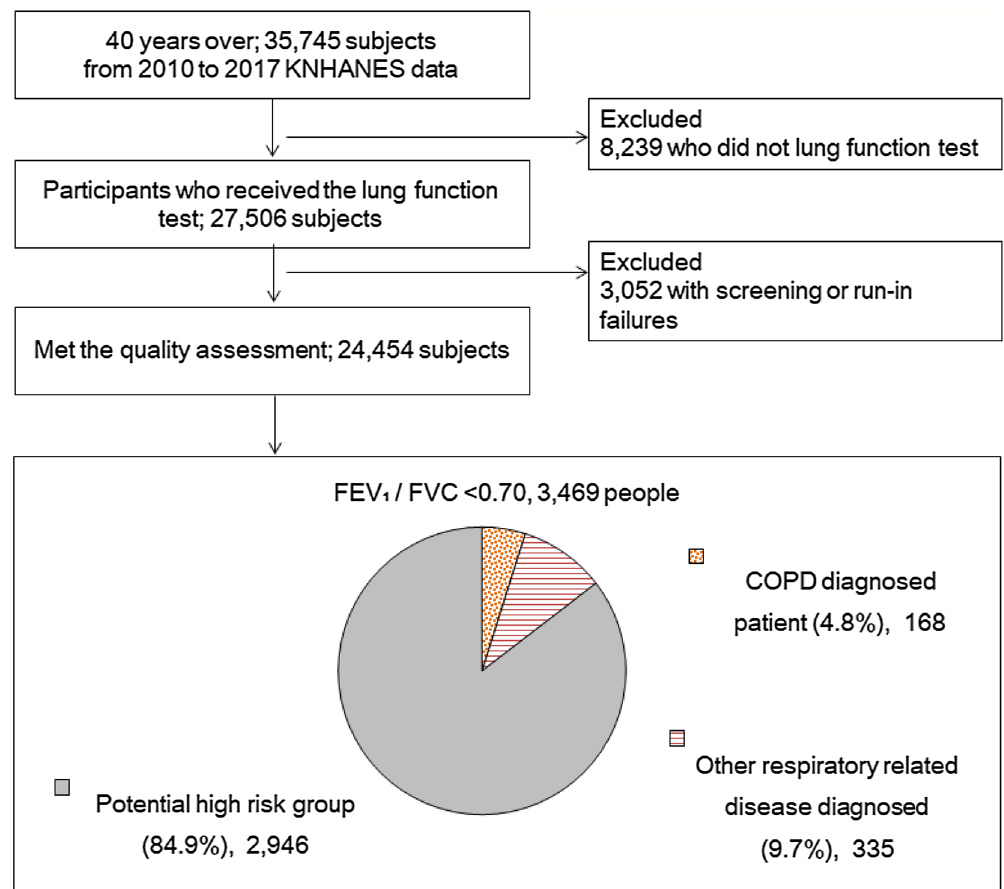
Figure 1. Flow diagram for study subject. COPD chronic obstructive pulmonary disease, KNHANES Korea National Health and Nutrition Health Examination Survey, FEV 1 forced expiratory volume in one second, FVC forced vital